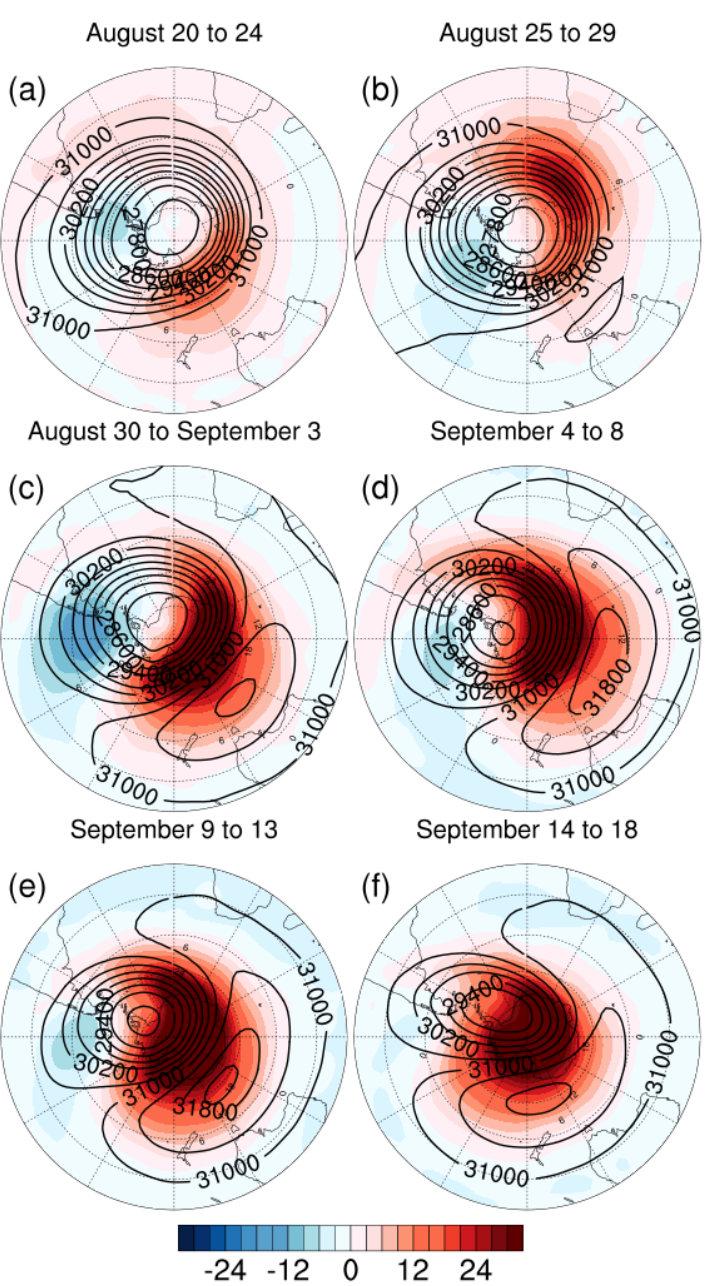
Figure 2. Temporal–spatial distributions of 5-days averaged geopotential height field (contours; unit: m) and temperature anomalies (shading; unit: K) at 10 hPa in the Southern Hemisphere during ( a ) 20–24 August, ( b ) 25–29 August, ( c ) 30 August–3 September, ( d ) 4–8 September, ( e ) 5–9 Septem-